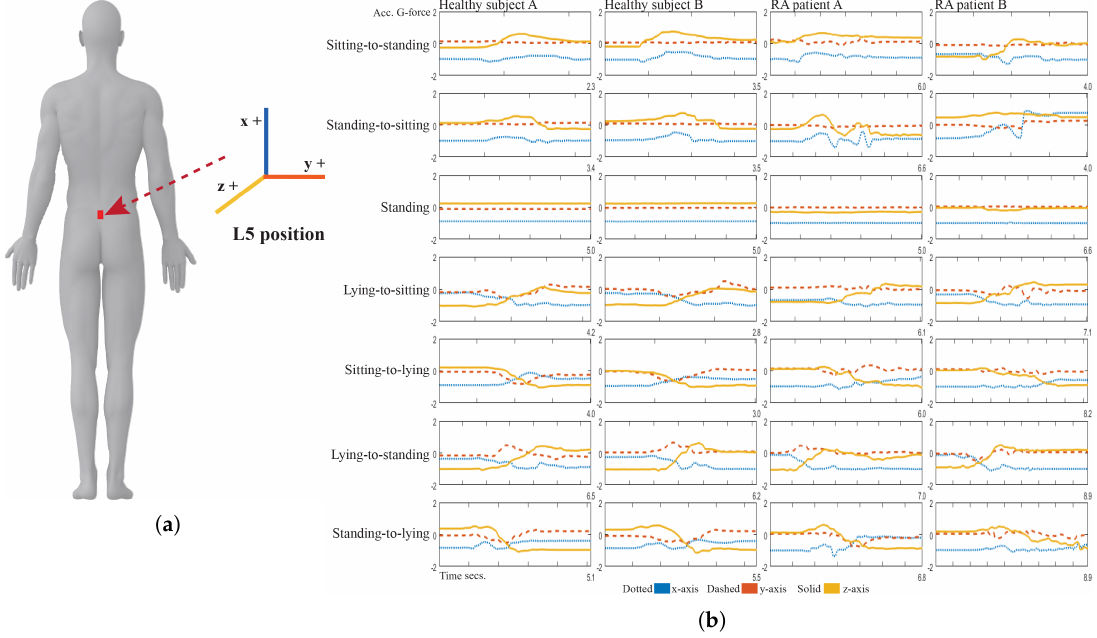
Figure 2. ( a ) Position of the accelerometer sensor and axes. ( b ) Signals captured by the accelerometer in the L5 position for seven exemplar activities. The signal plots depict the differences in signal pattern for healthy subjects and RA